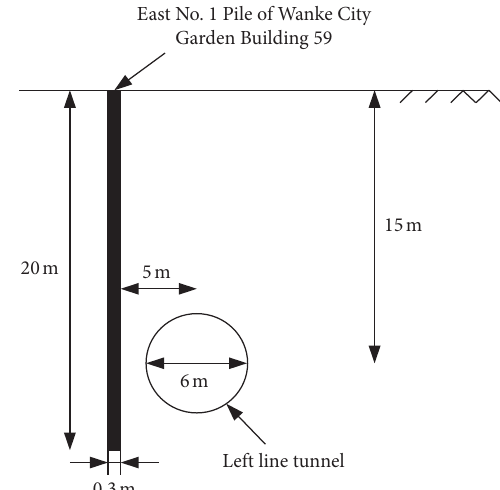
Figure 5: The position relation of pile and tunnel.